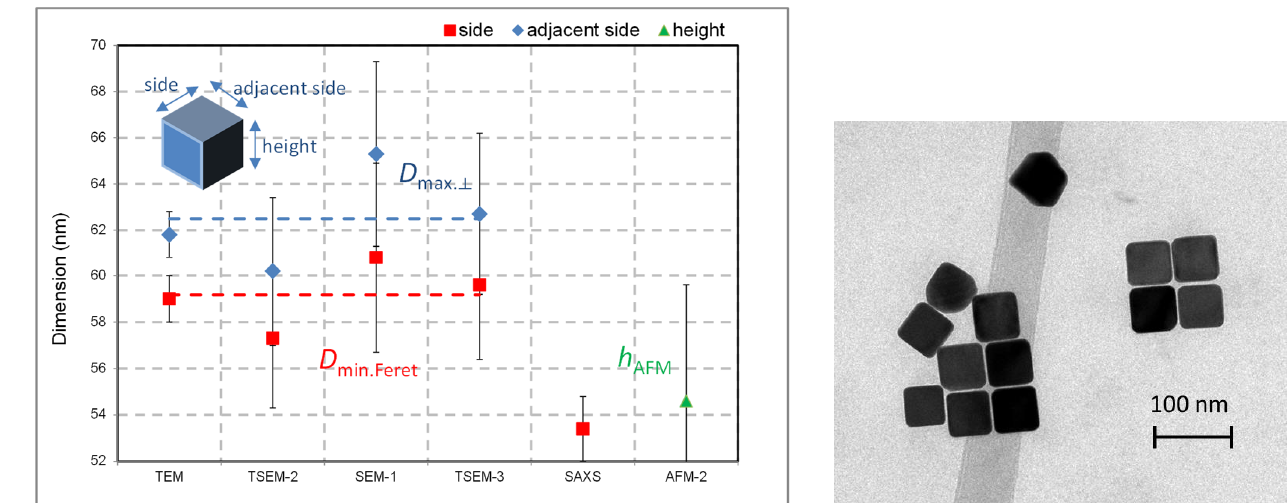
Figure 10. ( Left ) Size measurements of nPSize04 material (nanocubes) performed by different techniques and laboratories. ( Right ) TEM image of Au nanocubes. The uncertainty bars (k = 2) are also given with the mean values.